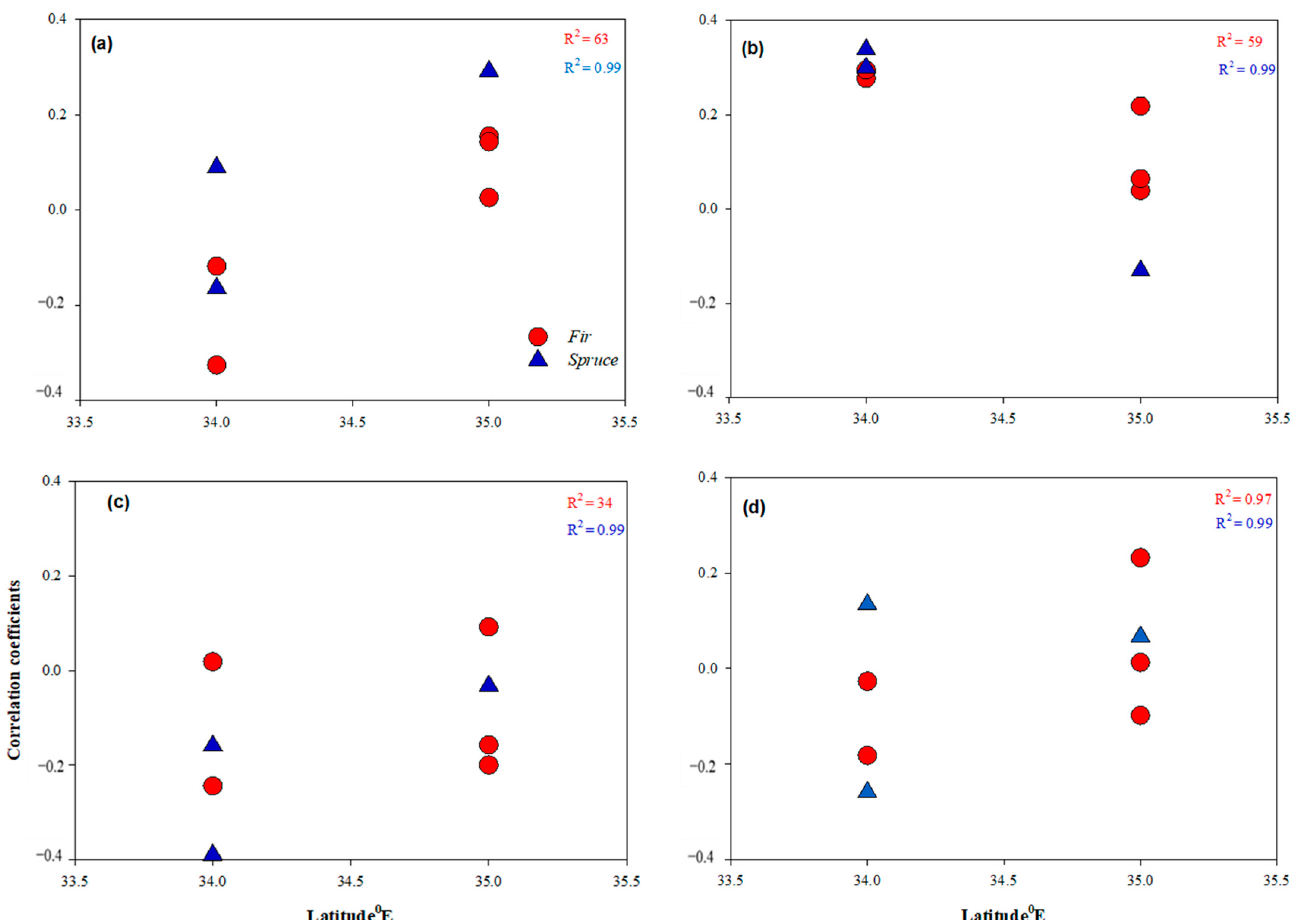
Figure 10. Variation of correlation coefficients between the tree-ring chronologies of spruce (blue triangles) and fir (red dots) and seasonal precipitation with latitudes during 1950–2018. ( a ) Winter (Dec–Feb), ( b ) spring (Mar–May), ( c ) summer (Jun–Jul), and ( d ) autumn (Sep–Nov).